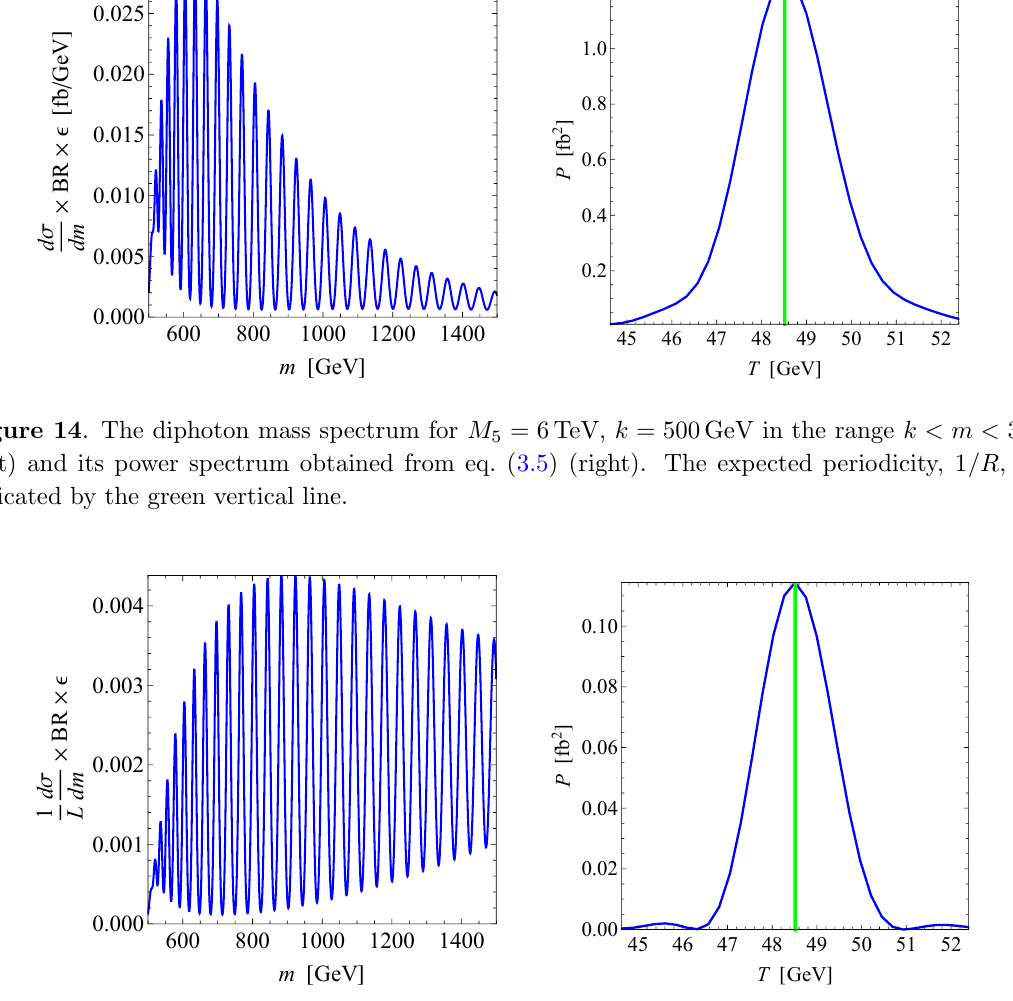
Figure 15 . Same as (cid:12)gure 14, but after dividing out the parton